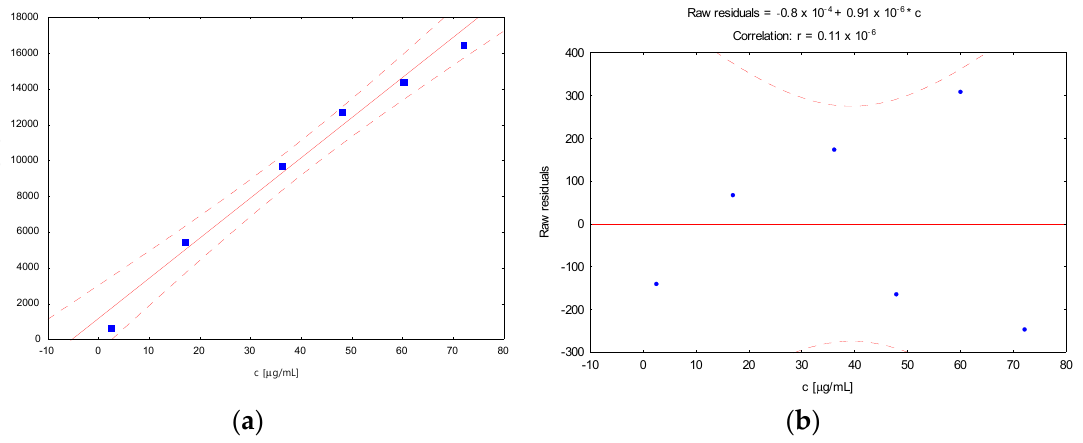
Figure 2. Plot of surface area [mm 2 ] vs. concentration of methanolic solution of ceftobiprole [µg/mL] ( a ) and ( b ) graph of residues.